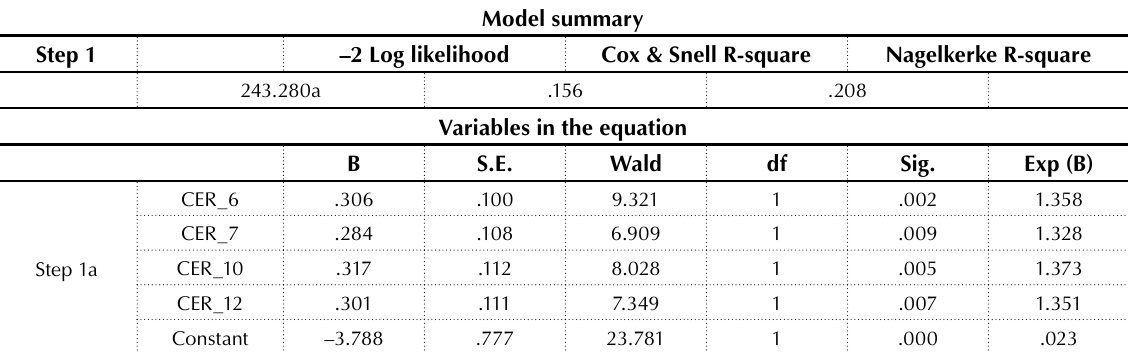
Table 4. Logistic regression analysis on CER